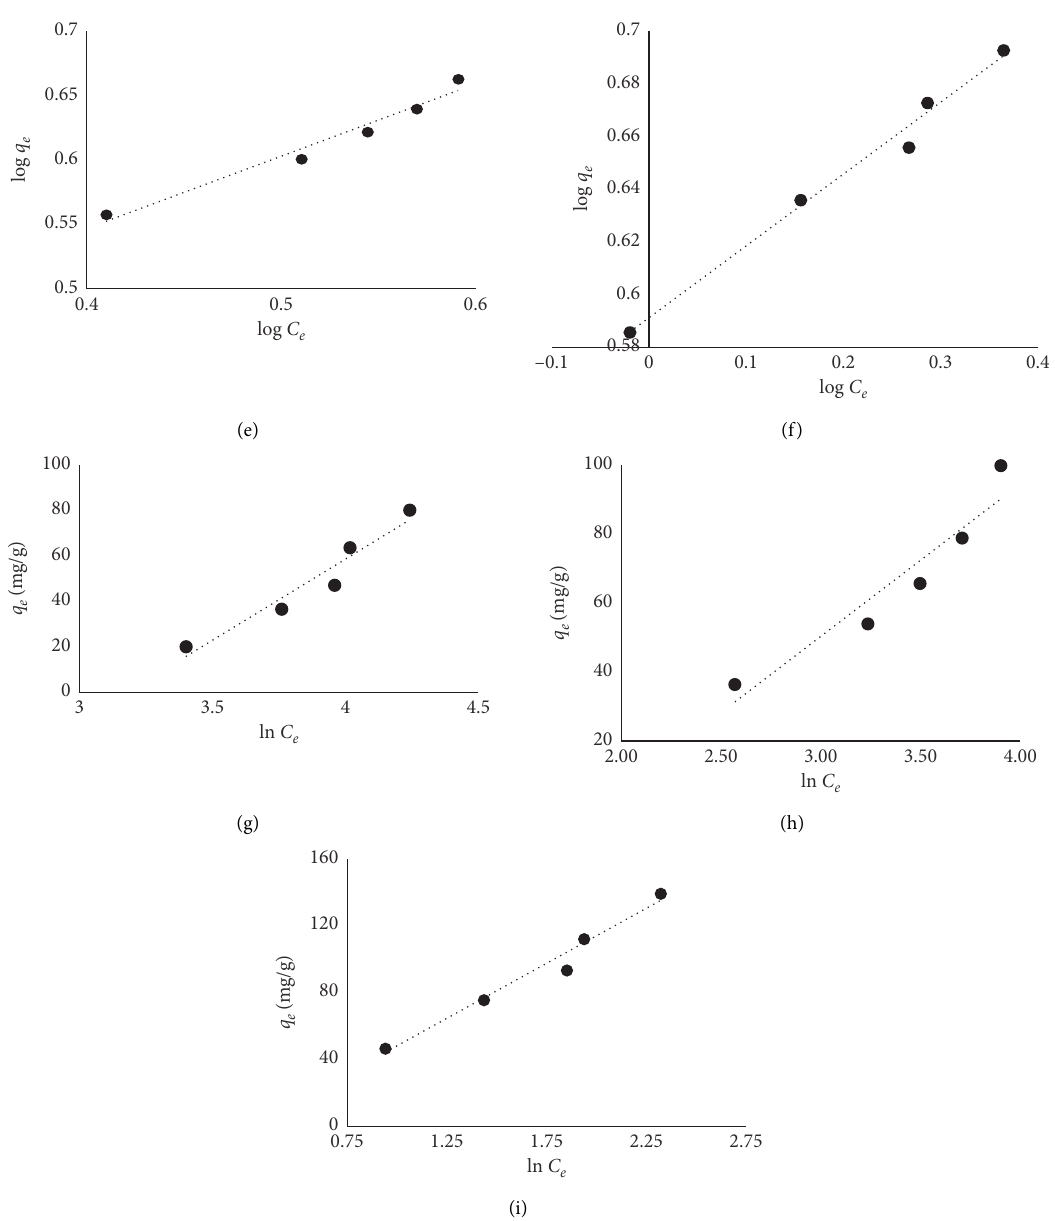
Figure 9: Adsorption isotherms fitted to the adsorption equilibrium data: (a–c) the Langmuir model at pH 1.5, 7, and 8.5, respectively; (d–f) the Freundlich model at pH 1.5, 7, and 8.5, respectively; (g–i) the Temkin model at pH 1.5, 7, and 8.5, respectively (150ppm, 25 ° C, and 150rpm). Table 3: Linear isotherm parameters for MB removal by MSN-Cys at 150ppm and 25 ° C.